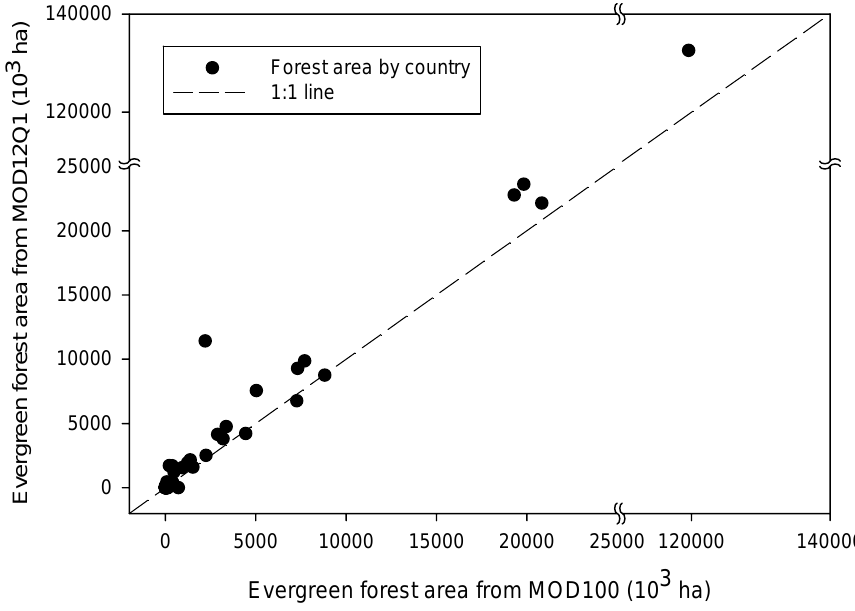
Figure 5. A country-level comparison for the area estimates of evergreen forests in tropical Africa between the LSWI-based algorithm in this study (MOD100) and the standard MODIS Land Cover Product (MOD12Q1) in